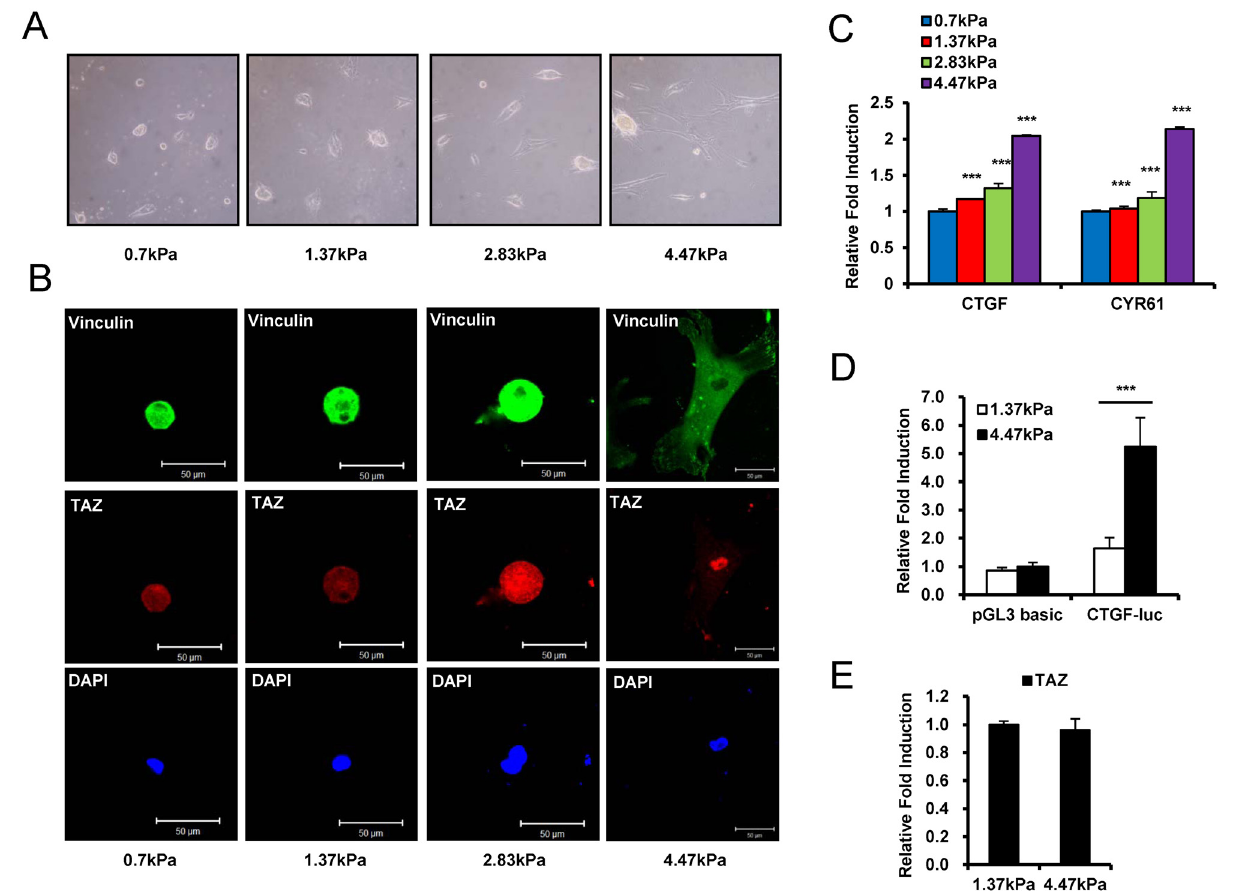
Fig 1. ECM stiffness regulates the cellular phenotype of human mesenchymal stem cells (hMSCs) and the localization and transcriptional activity of TAZ. (A) In indicated hydrogels, cell adhesion and morphology were visualized by light microscopy. Bright field images were taken 24hr after seeding. (B) ECM stiffness controls focal adhesion complex formation and TAZ localization. hMSCs were immunostained with an anti-vinculin antibody to detect focal adhesions (green fluorescence signal) 24 h after seeding. TAZ localization was visualized as a red fluorescence signal. DAPI was used to stain the cell nucleus. (C) The expression of TAZ target genes, including CTGF and CYR61 , were analyzed by qRT-PCR using the cells in panel (A). Target gene expression was normalized to the GAPDH expression. Data is shown as fold induction. Asterisks indicate statistical significance ( *** p < 0.005, t-test). (D) The luciferase reporter gene CTGF-luc was introduced into hMSCs. After 16 h, the transfected cells were plated on 1.37 or 4.47 kPa hydrogels. After 24 h, luciferase reporter gene activity was analyzed. The pGL3-basic luciferase reporter gene, which has no promoter for transcription, was used as a negative control. A Renilla luciferase-expressing vector was used as a transfection control. Luciferase activity was normalized to Renilla luciferase activity and is expressed as relative fold induction. ( *** p < 0.005, t-test). (E) hMSCs were seeded on a 1.37 or 4.47 kPa hydrogel, and twenty four hours after seeding, total RNAs were isolated and qRT-PCR analysis was assessed to see the expression of TAZ gene. Gene expression was normalized to GAPDH